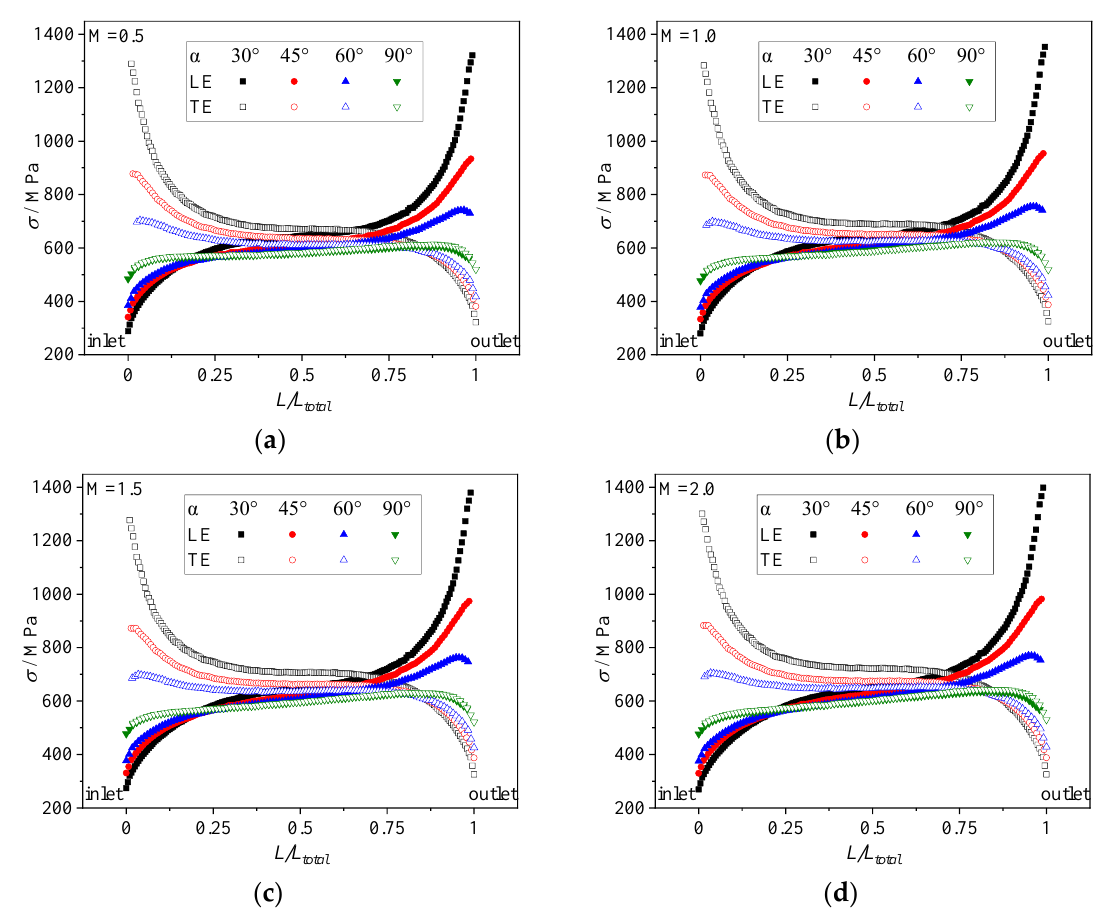
Figure 24. Thermomechanical stress distribution on the leading and trailing edge paths of research film hole. ( a ) M = 0.5. ( b ) M = 1.0. ( c ) M = 1.5. ( d ) M = 2.0.